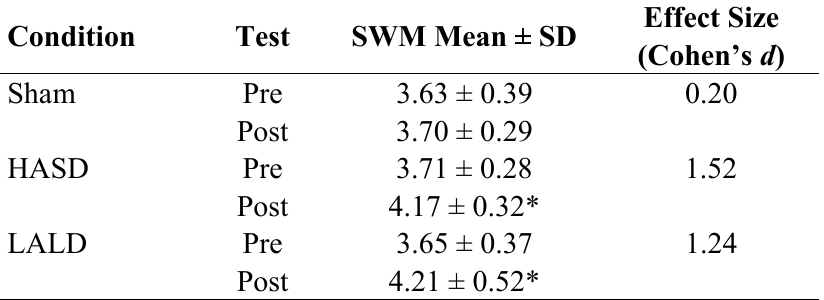
Table 1. Means and standard deviations by condition.